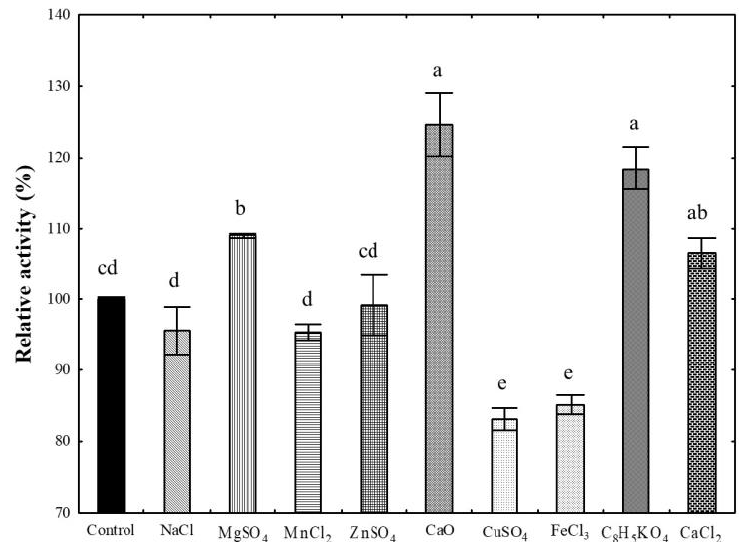
Figure 3. Effect of different salts (1 mM) on the activity of purified protease from Bacillus sp. P45. Bars are the means ± standard deviations of three independent experiments. The statistical analysis was conducted by ANOVA, followed by Tukey’s test. Equal lowercase letters represent no significant differences at the 5% level.